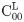
The kinetic scheme for the proposed model.The superscript of each state denote the gating mode that state is in. The two numbers in the subscripts respectively indicate the number of Ca2+ and IP3 bound to the channel in that state. The model has nine closed states: C00L, C20L, C30L, C32L, C34L, C04L, C04I, C24I, and C24H and three open states: O14I, O24I, and O24H. The transition rates between various states and the related flux parameters are listed in Tables 2 and 3 respectively.